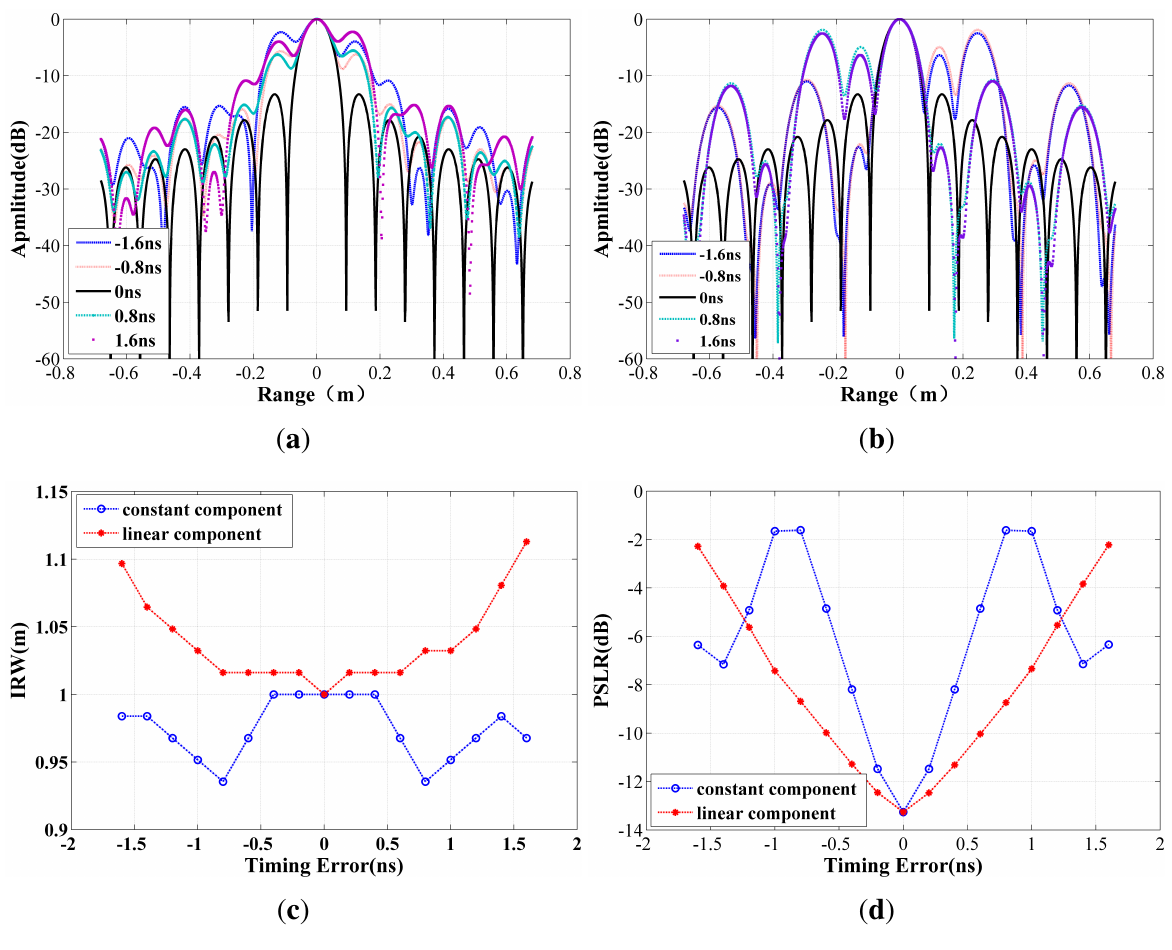
Figure 2. Synthesis results with different time error between sub-bands. ( a ) Impulse response function with linear component of the phase errors; ( b ) impulse response function with constant component of the phase errors; ( c ) impulse response width (IRW) versus time error; ( d ) peak side-lobe ratio (PSLR) versus time